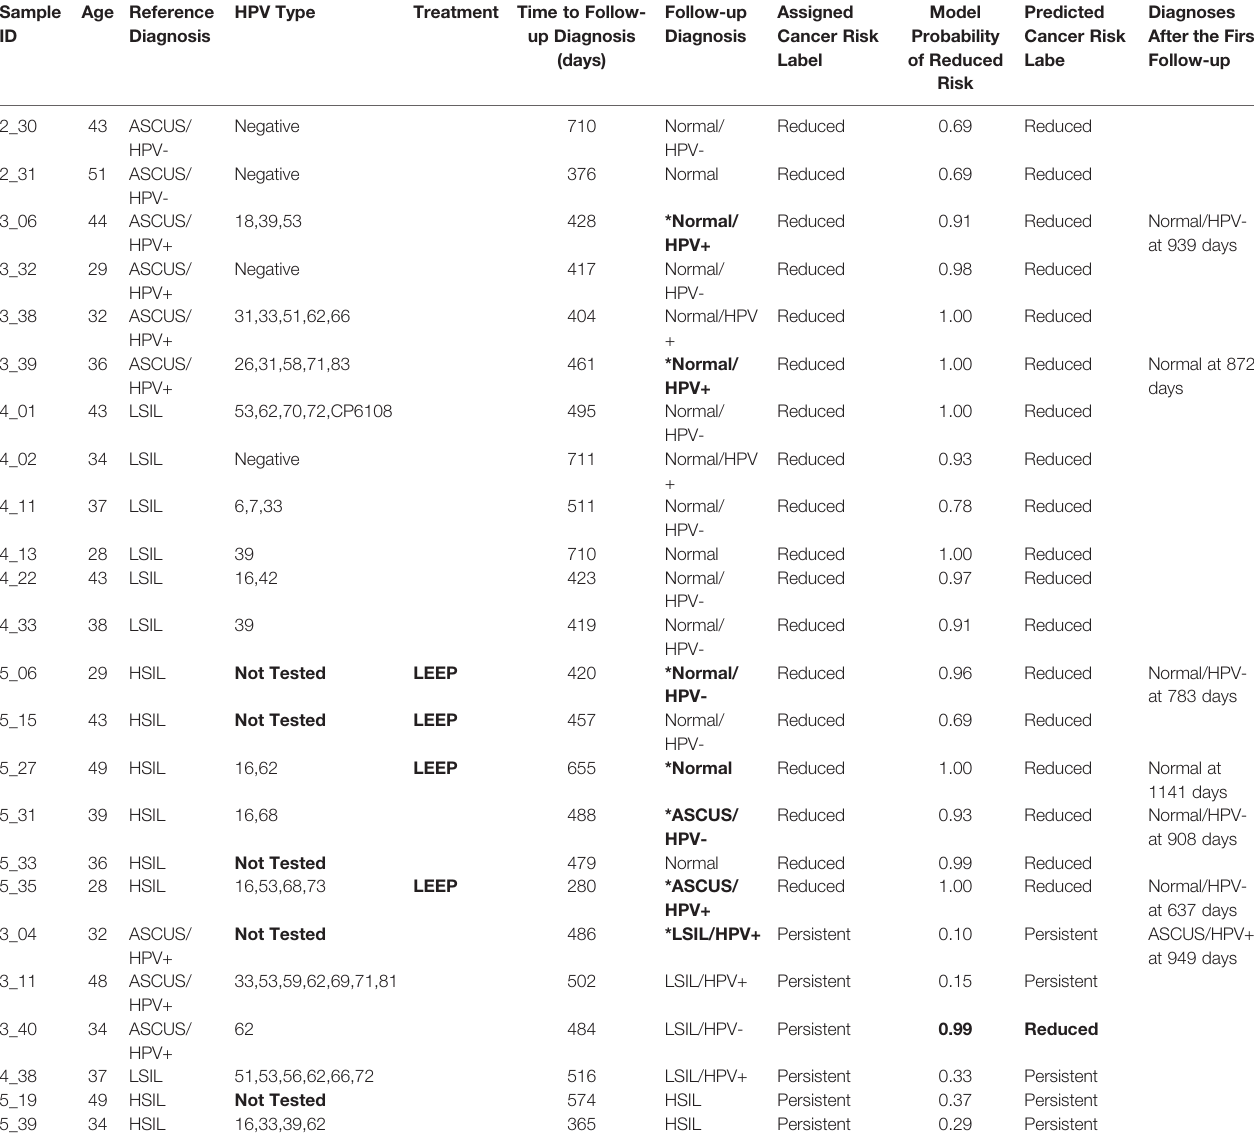
TABLE 1 | The fi rst (column 3) and second (column 7) cytology and hrHPV test results for the 24 women who had two sets of results. Sample Age Reference HPV ID Diagnosis